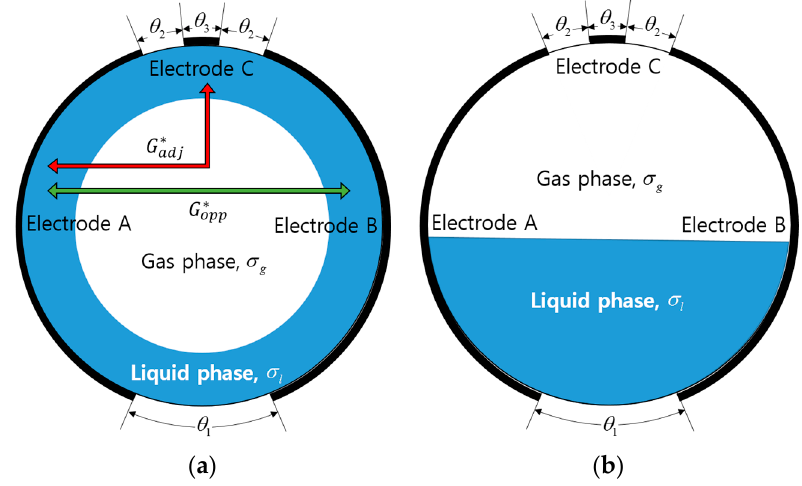
Figure 1. Configuration of electrodes in the proposed conductance sensor and typical flow structures considered: ( a ) Annular flow condition; ( b ) Stratified flow condition.